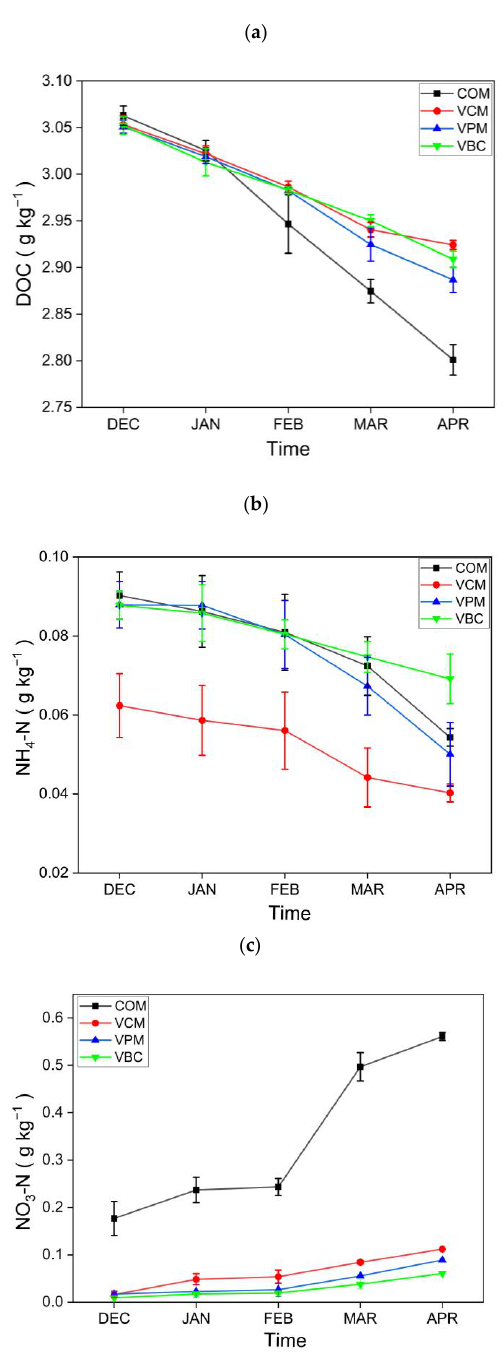
Figure 4. Dissolved organic carbon: ( a ) nitrogen NH 4 − N, ( b ) NO 3 − N content, ( c ) content in all treatments. Error bars represents standard errors ( n =